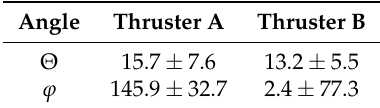
Table 2. The determined average thrust directions of thruster A and